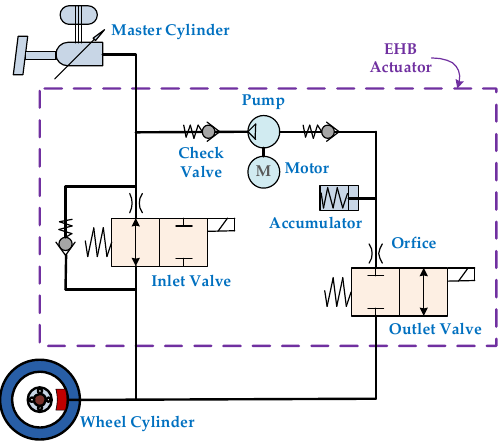
Figure 1. Hydraulic circuit of EHB actuator between master cylinder and wheel cylinder.